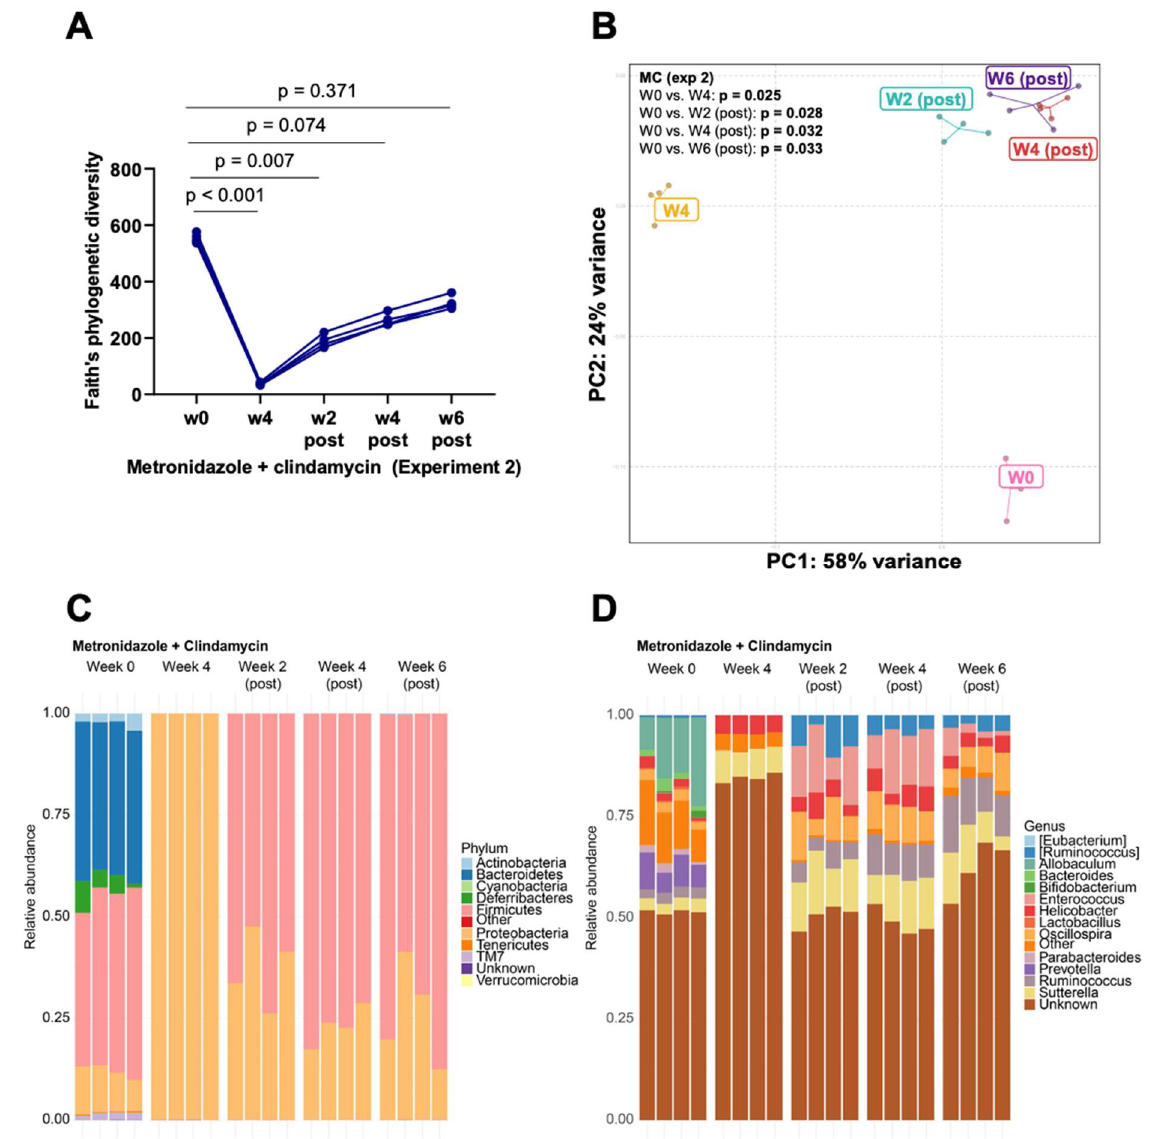
Figure 6. An independent experiment repeated with metronidazole + clindamycin treatment pro- duces a reproducible result. Bacteroides did not repopulate the gut in a six-week convalescence period ( A ) α-diversity measured using Faith’s phylogenetic index. p values for comparison between the baseline and the different time-points are shown. n = 4. ( B ) Principal Coordinate Analysis plot of weighted Unifrac distances in the microbiota sequences in the mice treated with metronidazole + clindamycin ( C ) Stacked relative abundance plots at the phyla level ( D ) Stacked relative abundance plots showing microbiota differences at the genus level.